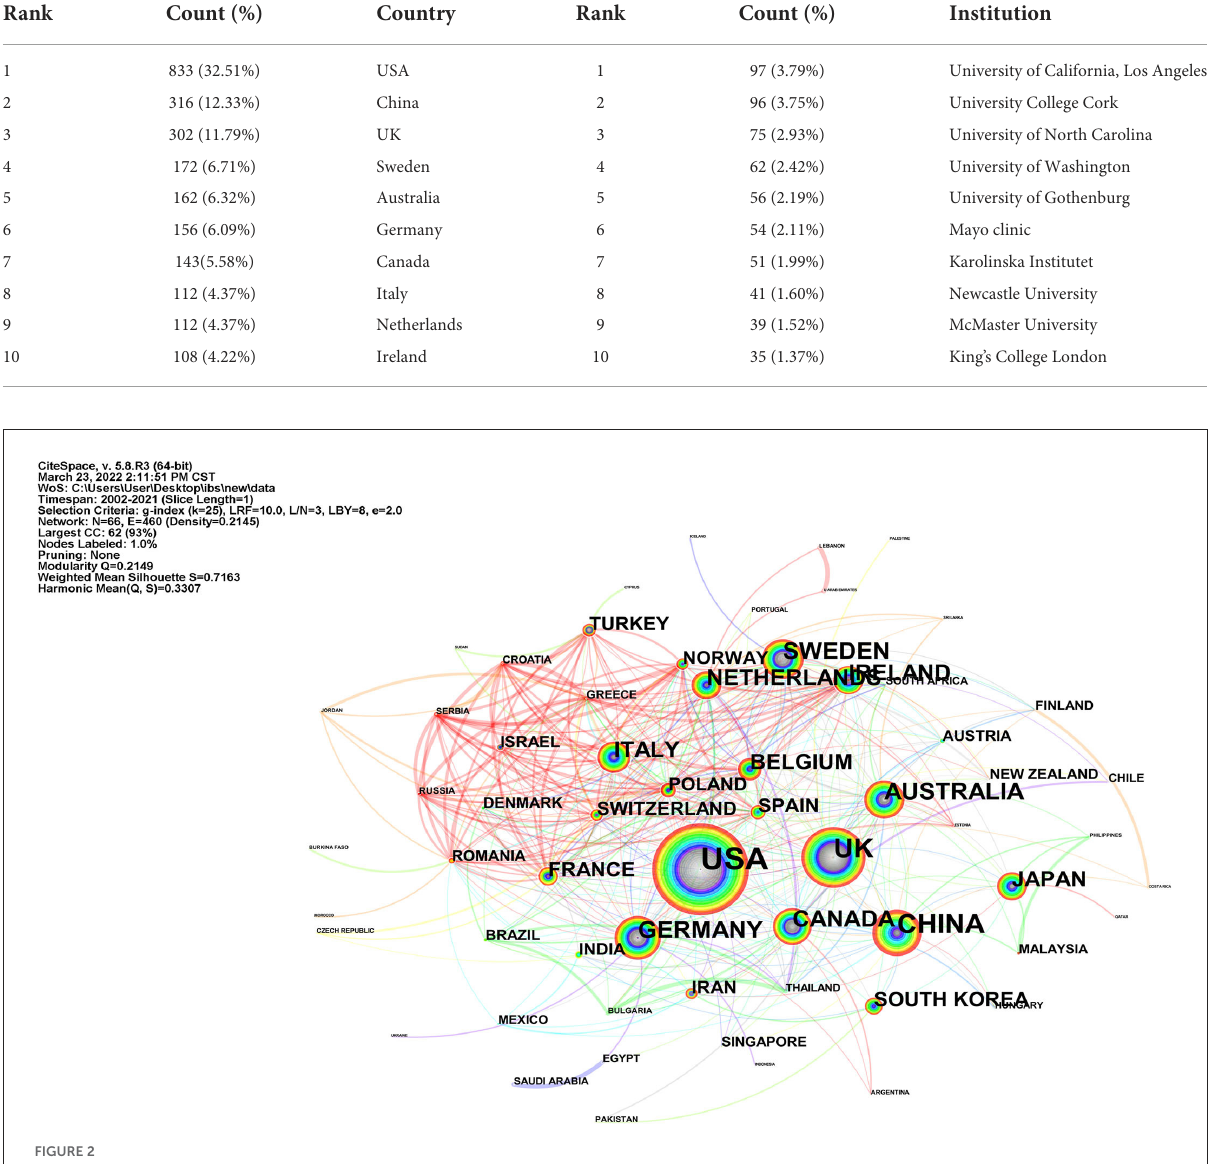
FIGURE2 Collaboration network of countries in IBS research related to anxiety or